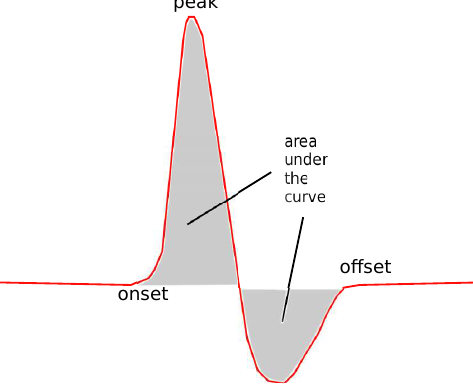
Figure 5. The expanded absolute area.